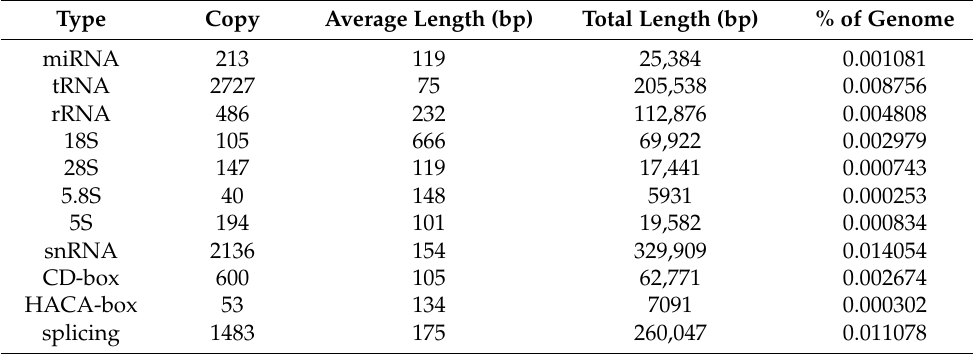
Table 7. Non-coding RNA genes in the genome of B. rotunda